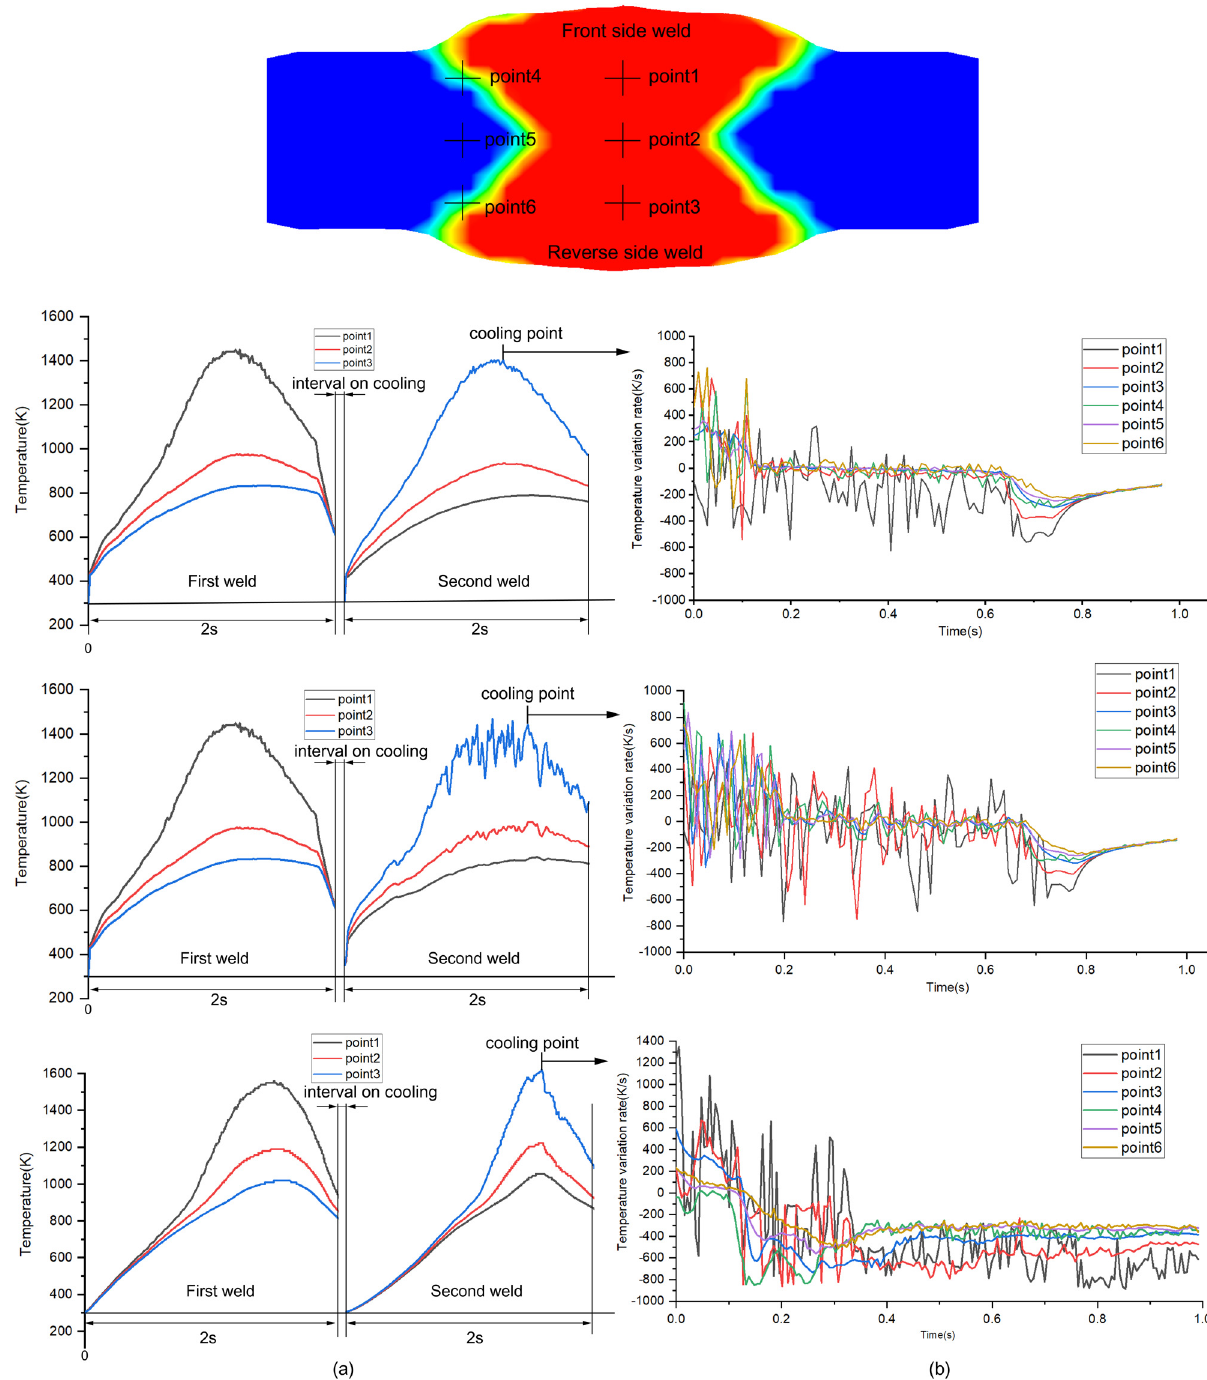
Figure 12: Process of temperature variation: ( a ) thermal cycle curve in the double - sided weld and ( b ) temperature variation rate in the cooling